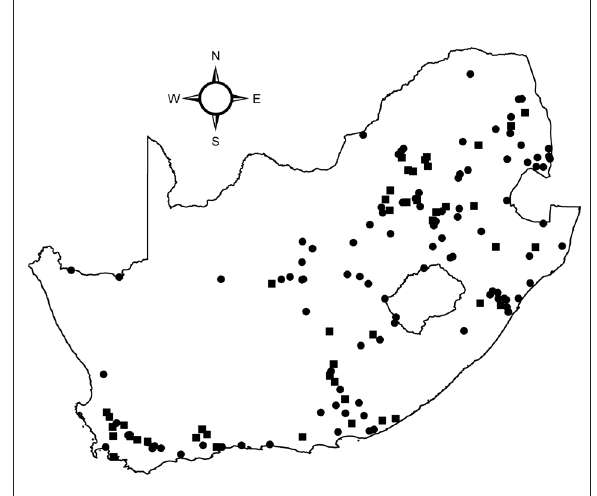
Location in South Africa of monitoring points used in the current analysis. Circles indicate points from which data were used to derive estimates of national nutrient levels. Squares